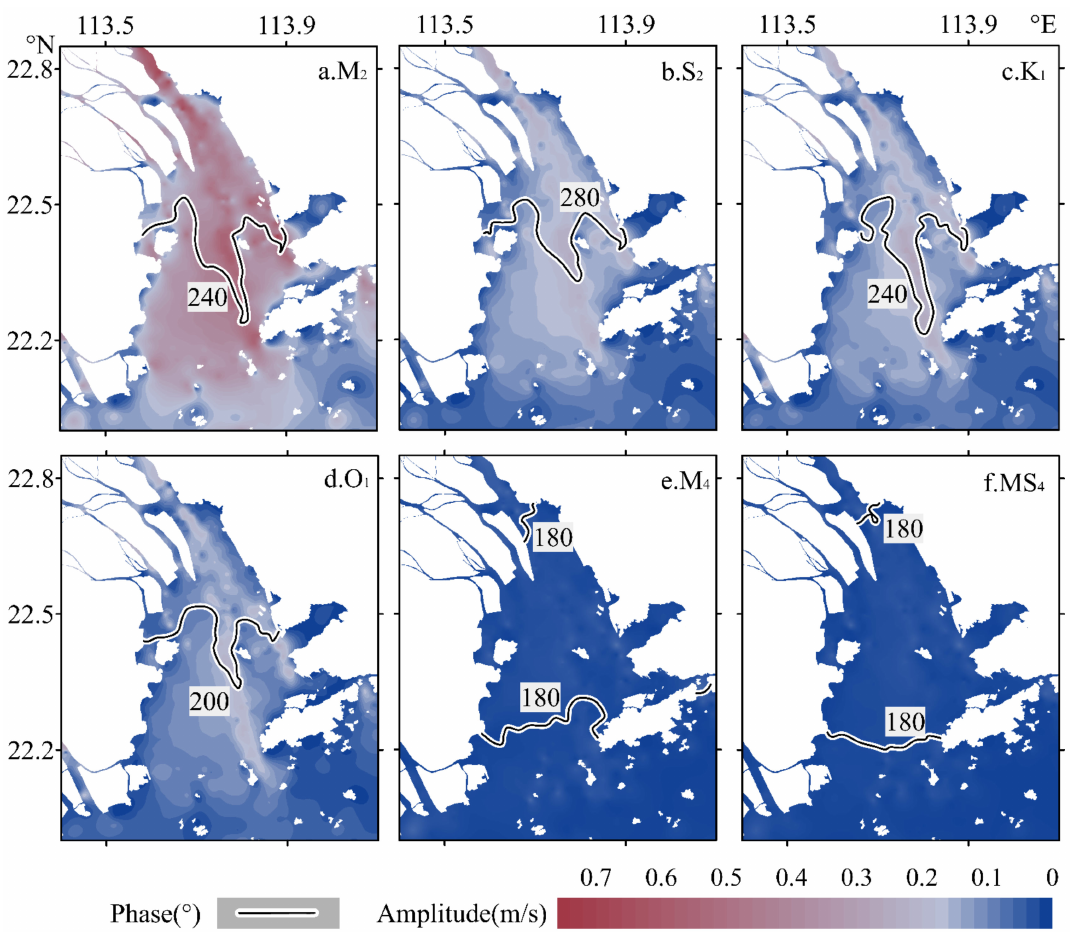
Figure 5. The spatial distribution of the amplitudes (color images) and phases (black contours) of the major tidal